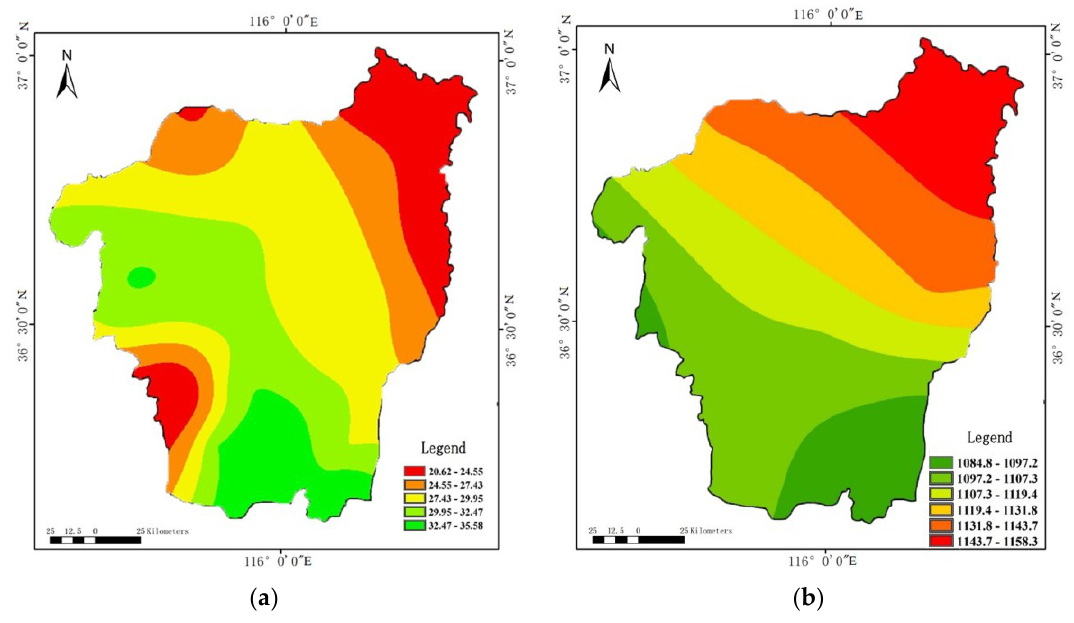
Figure 11. Spatial distribution map of ( a ) groundwater level and ( b ) evapotranspiration.